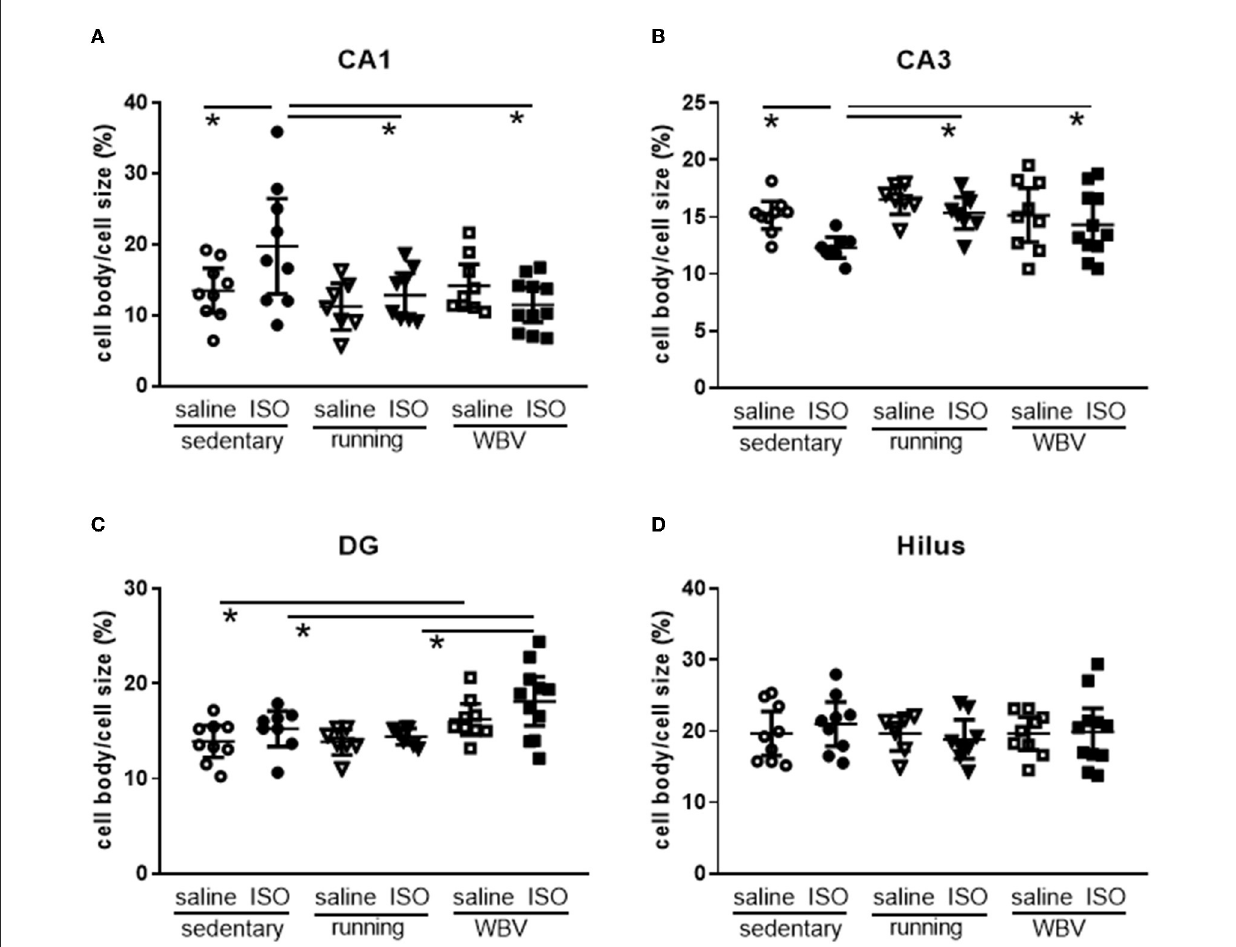
FIGURE6 (A) CA1, (B) CA3, (C) DG, and (D) Hilus. Measurement of microglia activity as cell body/cell size in the different areas of the hippocampus in saline- or isoproterenol (ISO)-treated rats, under sedentary conditions ( n = 8 and n = 9, respectively), or after 5 weeks of exercise training (running; n = 6 and n = 8, respectively) or whole-body vibration (vibration; n = 8 and n = 10, respectively). *Significant difference between indicated groups ( p <